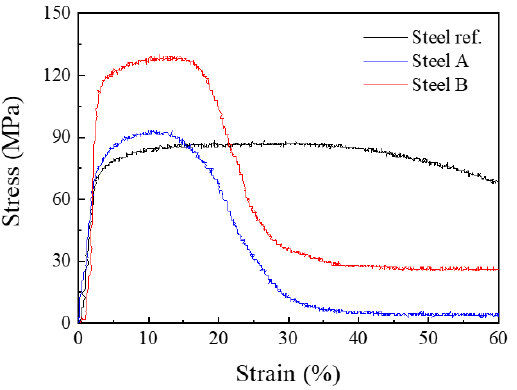
Figure 7. Engineering stress-strain curves at T T = 900 °C of Steel ref, A, and B